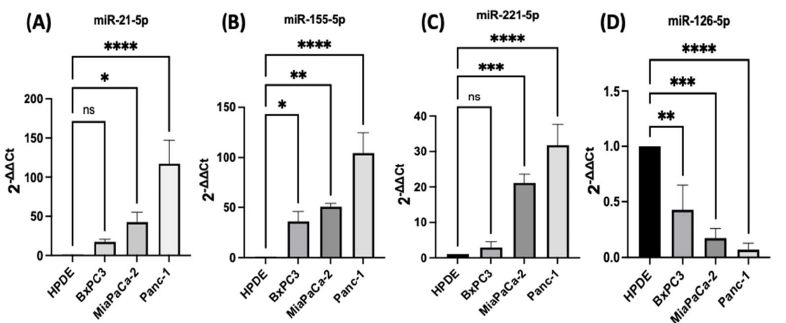
Figure 1. RT-qPCR analysis of miRs levels miR-21, miR-221, miR-155, and miR-126 in PDAC cell lines (BxPC3, MiaPaCa-2, Panc-1, compared with HPDE). ( A ) miR-21-5p relative expression was significantly increased in MiaPaCa-2 and Panc-1 but not in BxPC3 PDAC cell lines. ( B ) miR-155-5p relative expression was significantly overexpressed in BxPC3, MiaPaCa-2, and Panc-1 PDAC cell lines. ( C ) miR-221-5p relative expression was significantly upregulated in MiaPaCa-2 and Panc-1 but not in BxPC3. The column graphic represents the average of three replicates of RNA isolated from each cell line. ( D ) miR-126-5p relative expression was significantly reduced in PDAC cell lines. The column graphs represent the average of three replicates of RNA isolated from each cell line. Data normalized according to RNU6 expression by fold analysis ( n =3, p < 0.05 for all). p -values are indicated as: * p ≤ 0.05; ** p ≤ 0.01; *** p ≤ 0.001; **** p ≤ 0.0001; error bars indicate standard deviation (SD).